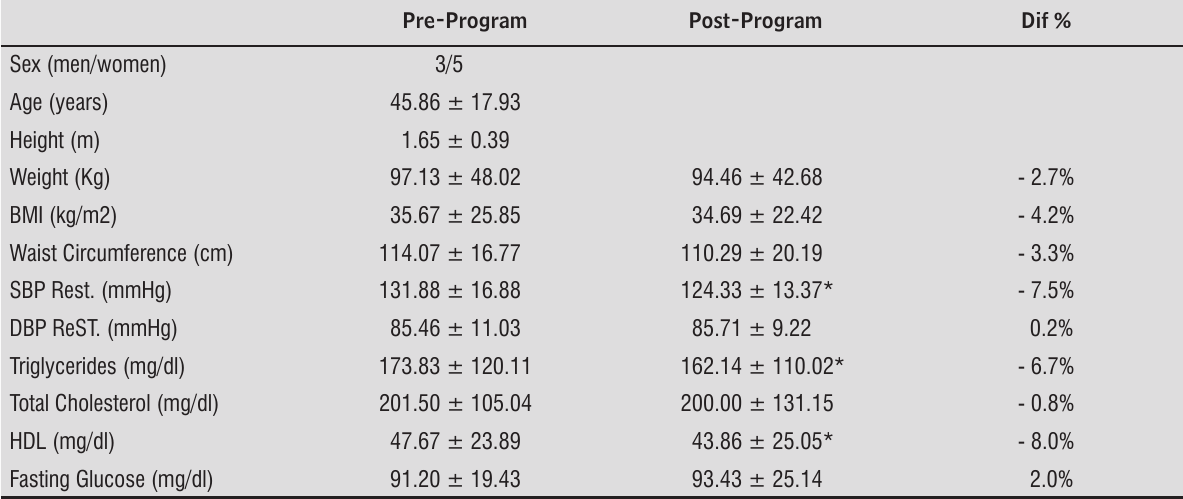
Table 1 – Sample characteristics and the percentage change after the LMP